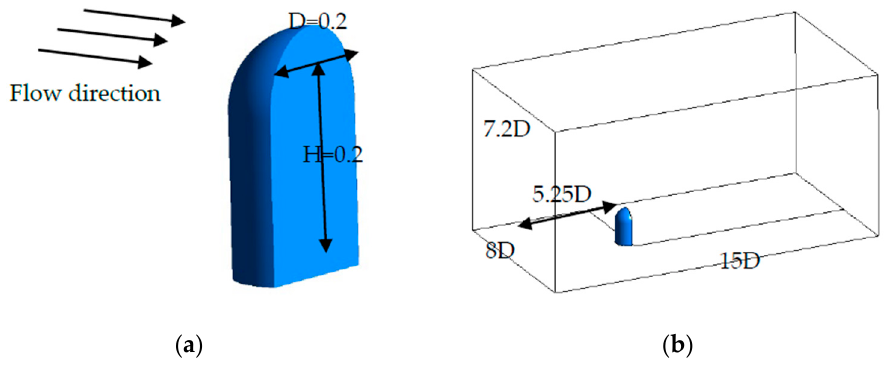
Figure 1. ( a ) The model of an idealized side mirror. ( b ) The dimension of the computational domain and the distance between the inlet of the side mirror and computational domain.